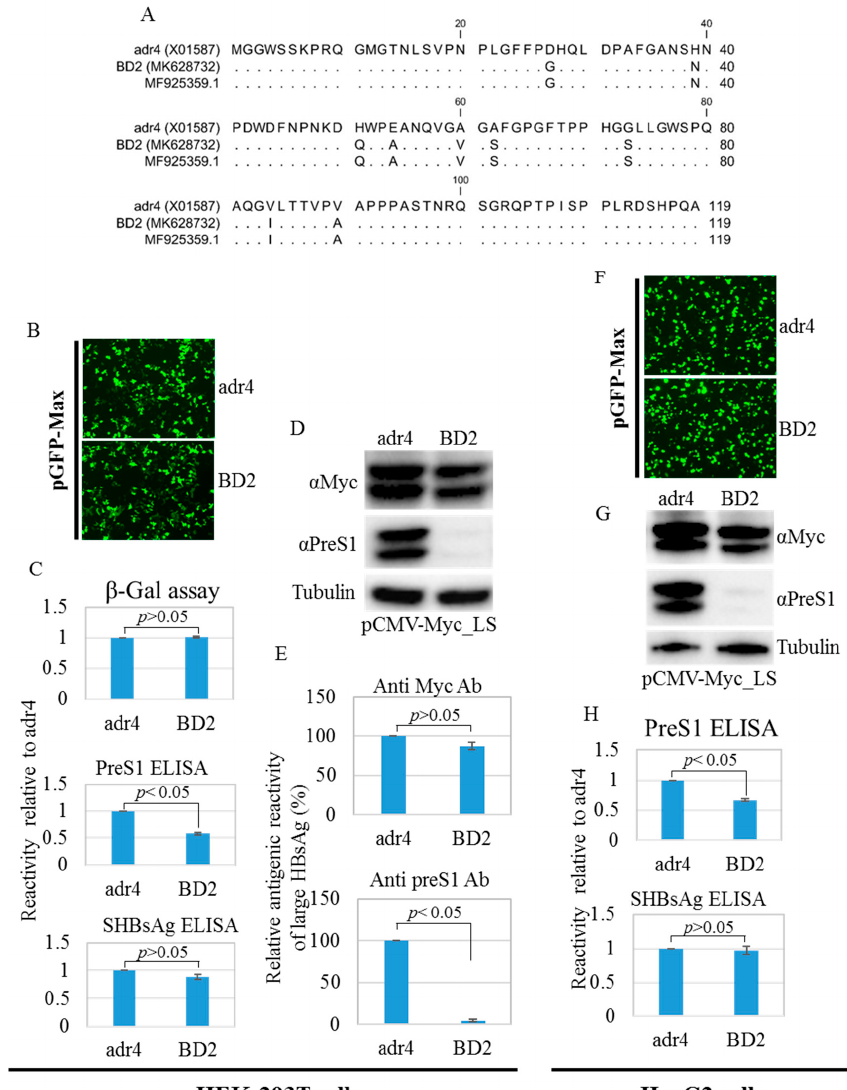
Figure 4. PreS1 region amino acid mutations, western blot analysis, and ELISA. ( A ) Amino acid mutations in the preS1 region compared to the reference HBV strain adr4. Mentioned cells were co-transfected with pCMV-LS carrying a large HBsAg coding sequence and pGFP-Max or pSV- β -Gal and incubated for 48 h. ( B , F ) Transfection efficiency was tested by detecting GFP signals from the co-transfected cells. Pictures were taken using EVOS FL Auto with 10×/0.30 magnification. ( C , H ) Cells were lysed and subjected to ELISA. ELISA results were normalized to the β -Gal assay. ( D , G ) Lysed cells were further subjected to SDS-PAGE followed by western blotting analysis using preS1 and Myc tag antibodies. The β -tubulin used as a loading control. ( E ) Relative antigenic reactivity of large HBsAg by western blot. Data were generated from the densitometry of western blot band intensities detected by preS1, Myc tag, and β -tubulin antibodies. Relative reactivity of large HBsAg was calculated. Each experiment was performed at least three independent times, and results are shown as mean ± SD. p ≤ 0.05 was considered as statistically significant.